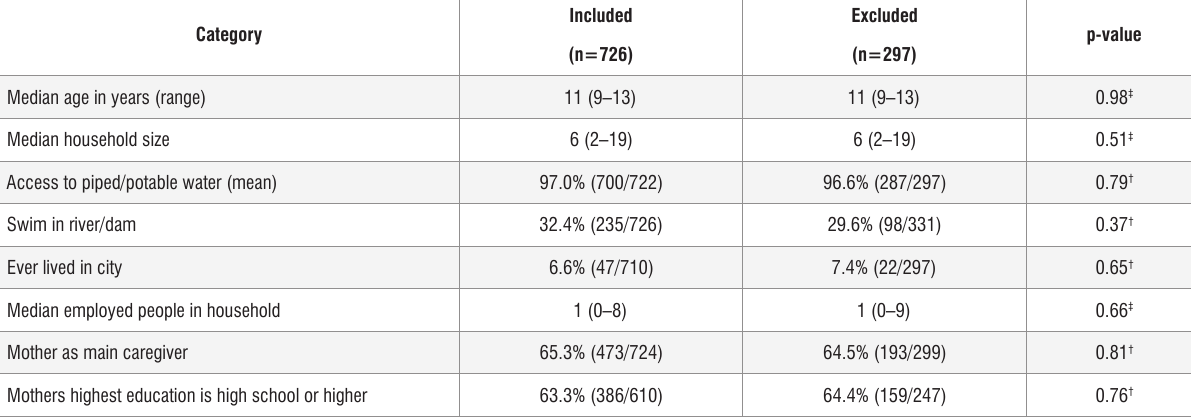
Comparison of characteristics of included cases (stool, urine and questionnaire provided) and excluded cases